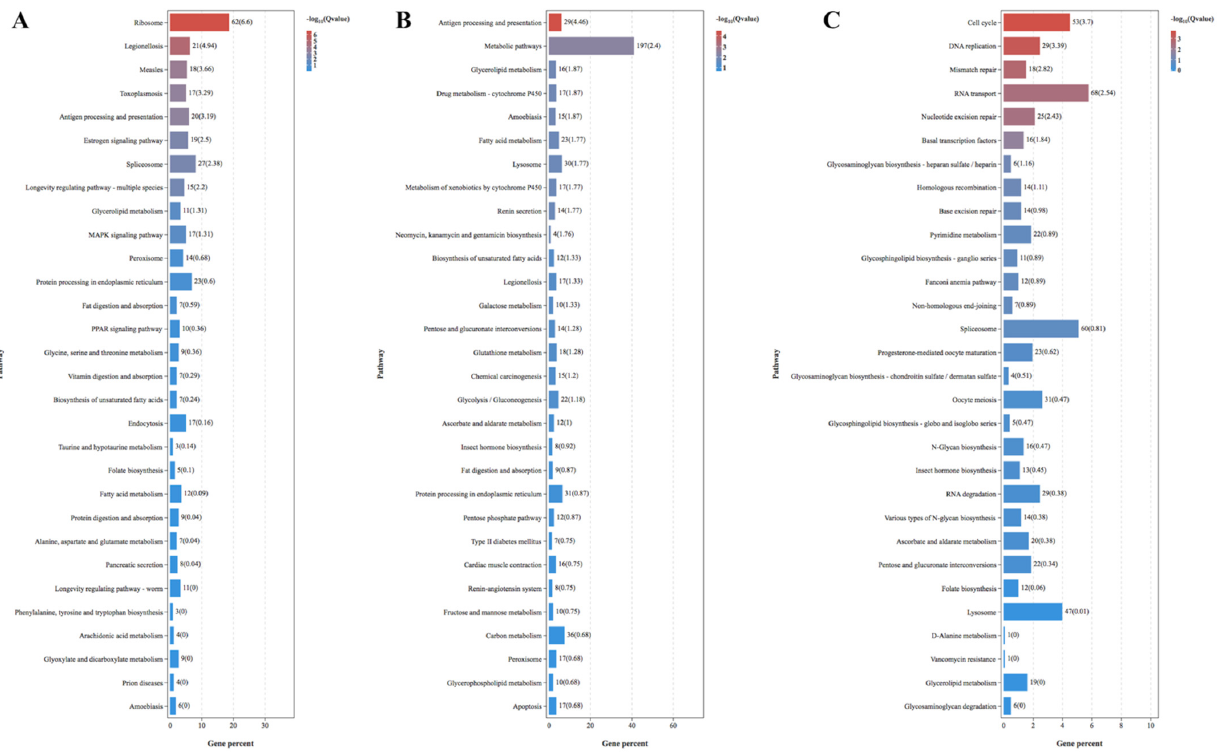
Figure 3. Pathway represents KEGG analysis of the differentially expressed genes (DEGs) in response to Sitobion miscanthi feeding on antibiotics and BYDV − PAV. ( A ) Top 30 pathway rep- resents KEGG analysis of STY − Free − vs. − STY − Vir. ( B ) Top 30 pathway represents KEGG analysis of STY − Free − vs. − STY − Rif + − Vir. ( C ) Top 30 pathway represents KEGG analysis of STY − Free − vs. − STY − Amp + − Vir. cient vector against 63 proteins upregulated for the efficient vector.